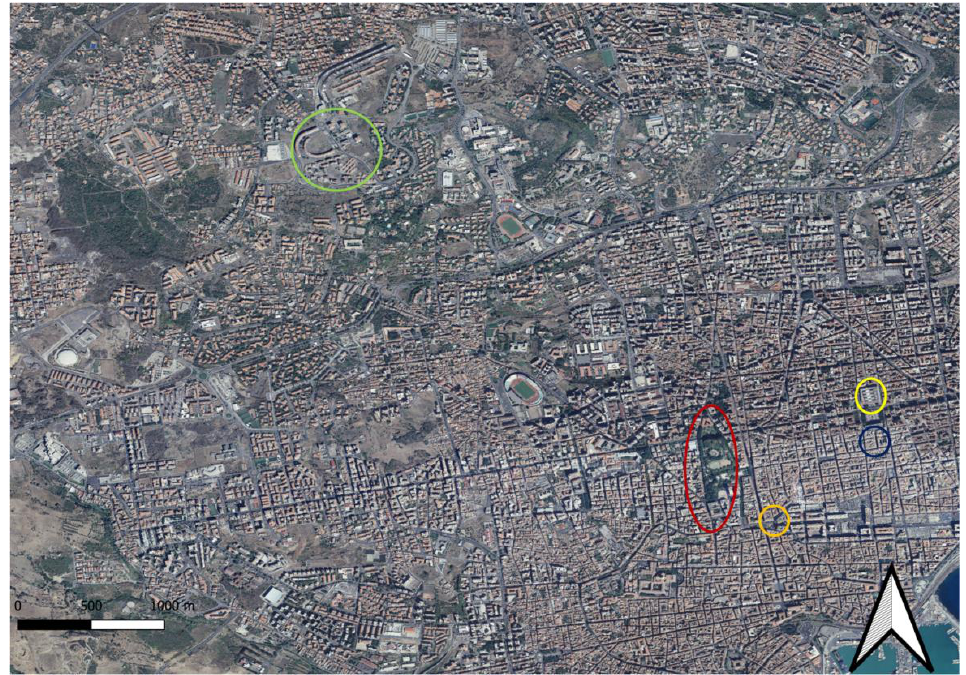
Figure 3. Ortophoto of Catania city, red circle highlights Villa Bellini, yellow circle the courthouse, blue circle the skyscraper, orange circle Stesicoro square and green circle is San Nullo district. Table 1. Overpass time of the satellite for the twelve investigated days. Greenwich Mean Time (GMT).